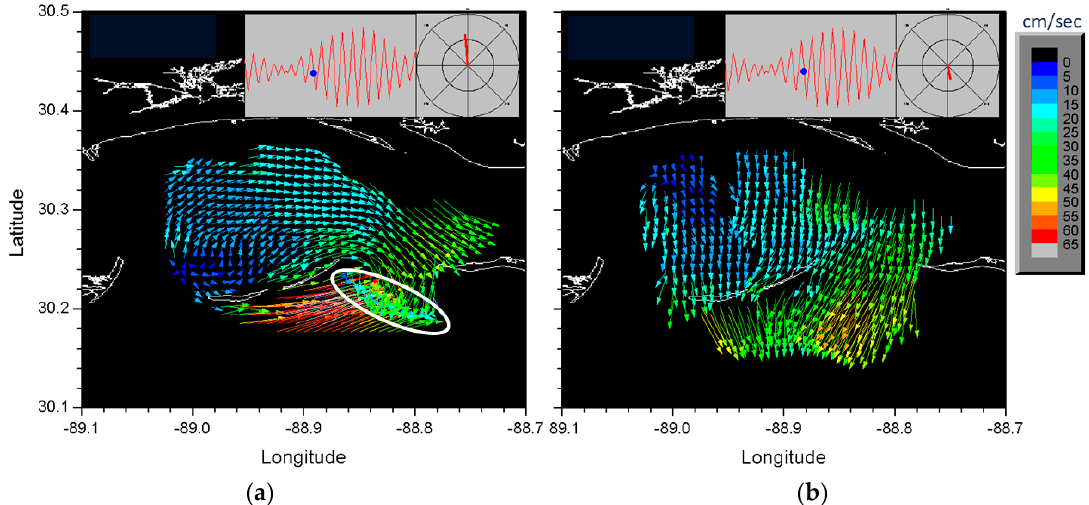
Figure 1. Coastal Ocean Dynamics Application RADAR (CODAR) surface currents in Mississippi Sound, south of Biloxi Bay, Mississippi Sound. Blue dot in top panel of each figure indicates the tidal stage corresponding to the currents. Wind rose in the right panel indicates wind direction. ( a ) Ebb flow, southerly wind (winds and tides oppose; front is observed, white oval); ( b ) Ebb flow, northerly wind (winds and tides reinforce; no front).